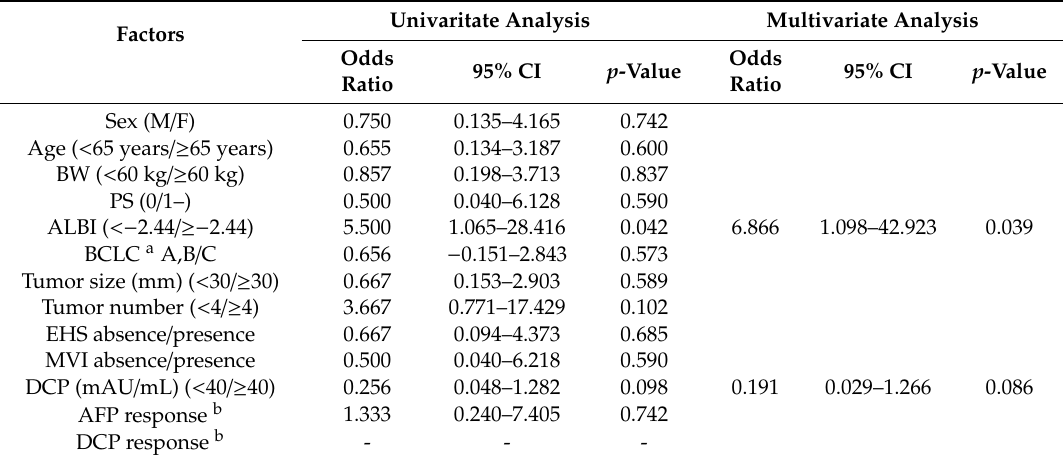
Univariate and multivariate analyses for factors a ff ecting objective response in the low-alpha-fetoprotein group.